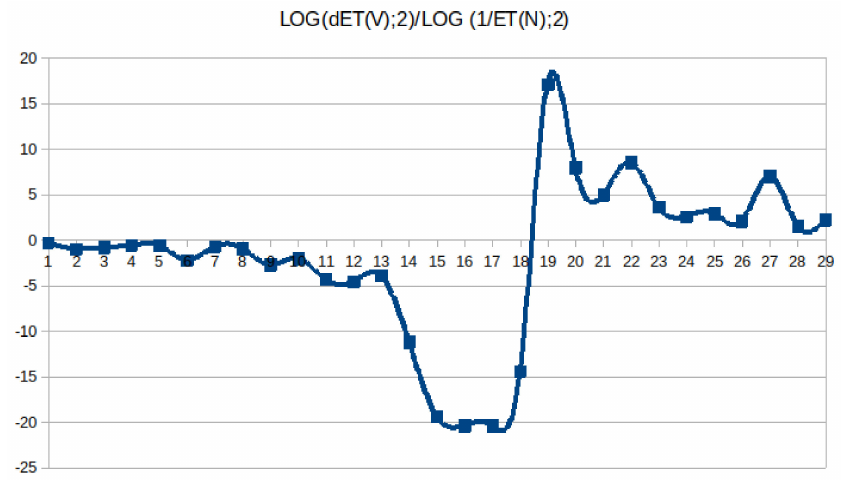
Figure 5. D for test